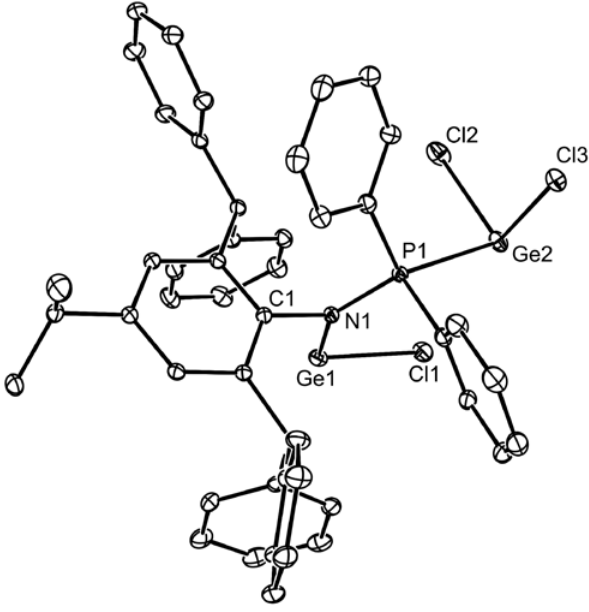
Figure 1: Thermal ellipsoid plot (30% probability surface) of the molecular structure of 1 (hydrogen atoms